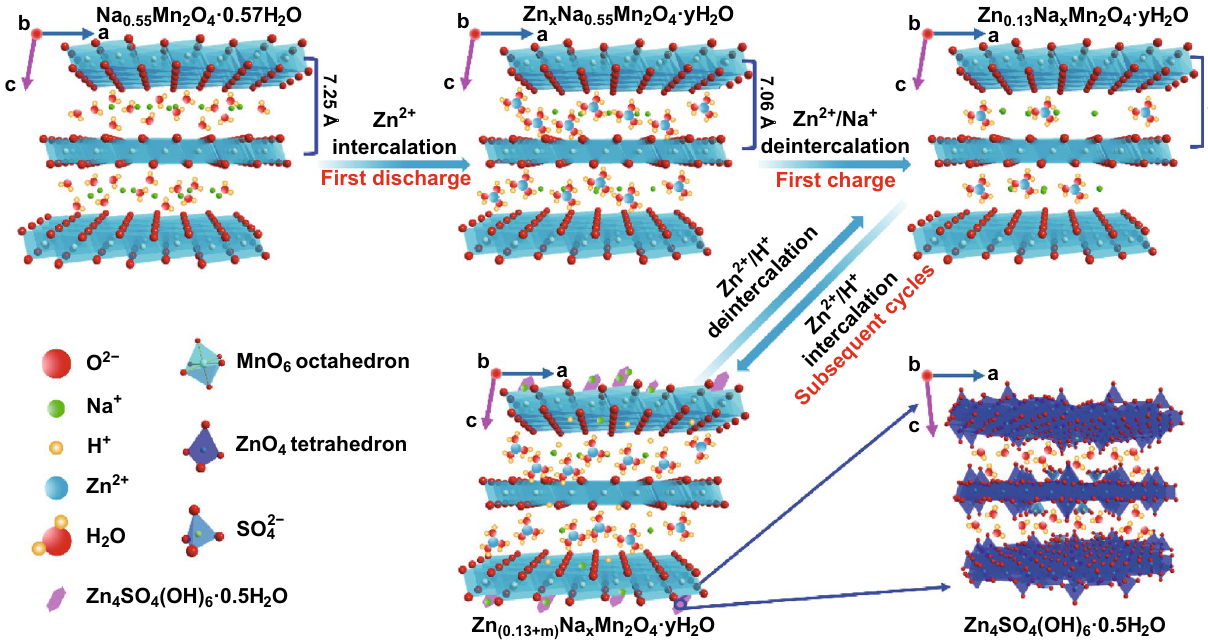
Fig. 6 Schematic illustration of the displacement/intercalation reaction mechanism in the first cycle, and the insertion/extraction mechanism of zinc ions in subsequent electrochemical discharge/charge